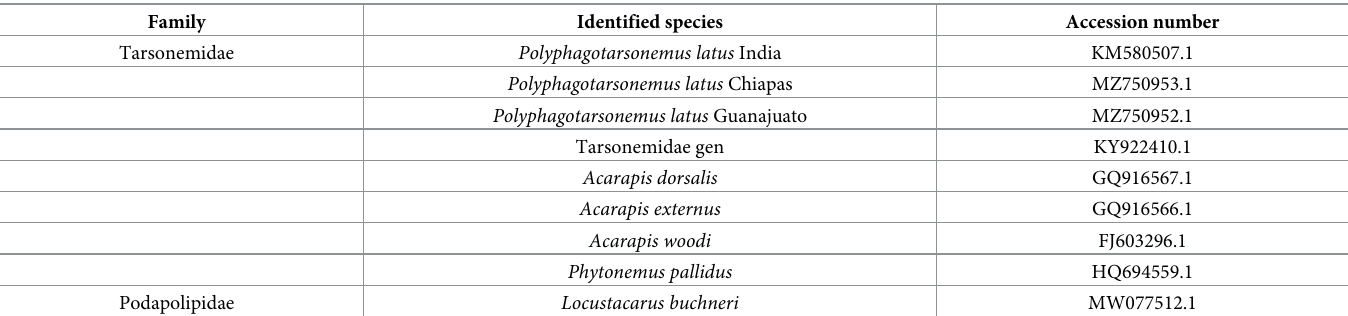
Table 1. List of species and GenBank accession numbers (family